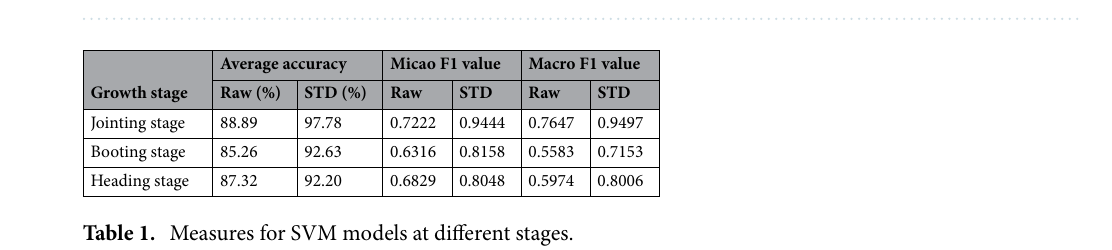
Figure 3. Difference spectra of diseased and healthy leaves at different stages. ( a ) Jointing stage; ( b ) booting stage; ( c ) heading stage.